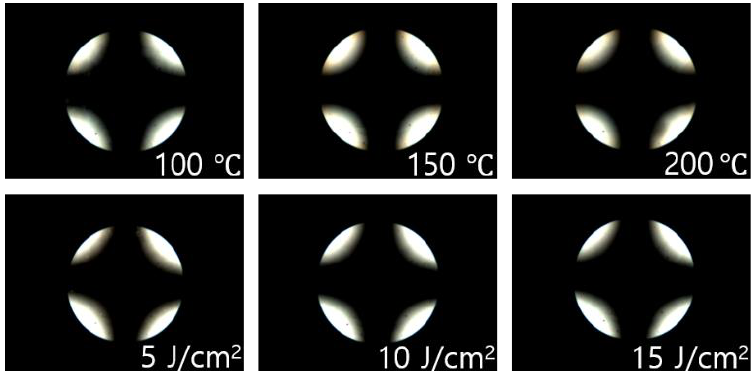
Figure 8. Concoscopic POM images of the LC cells made P4TB films, after thermal treatment at 100, 150, and 200 °C for 10 min and UV treatment at 5, 10, and 15 J/cm 2 , respectively.